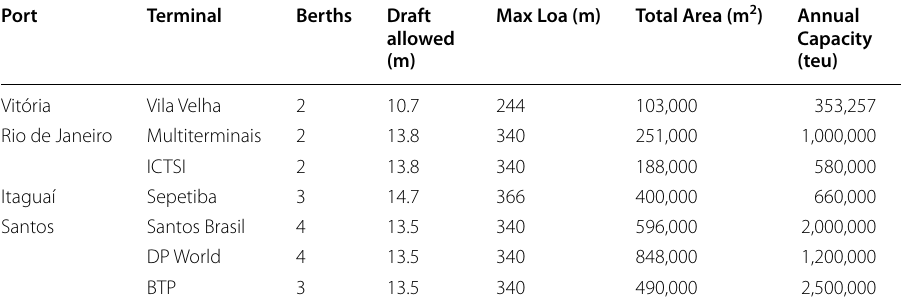
Table 2 Port infrastructure detailed by terminals in the Ports of Southeast Brazilian region